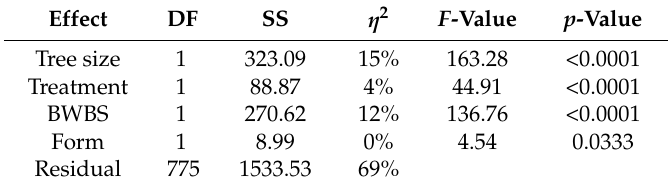
Table 6. ANCOVA for productivity (m 3 PMH − 1 ) data after square root transformation. Effect